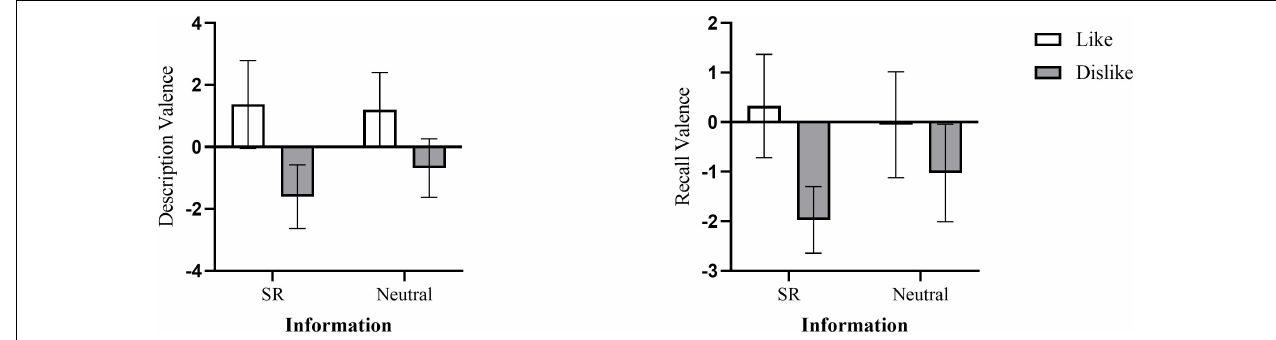
FIGURE 1 | Description valence ( left panel ) and recall valence ( right panel ) as a function of the audience’s attitude and the information (bars represent 95% confidence intervals).